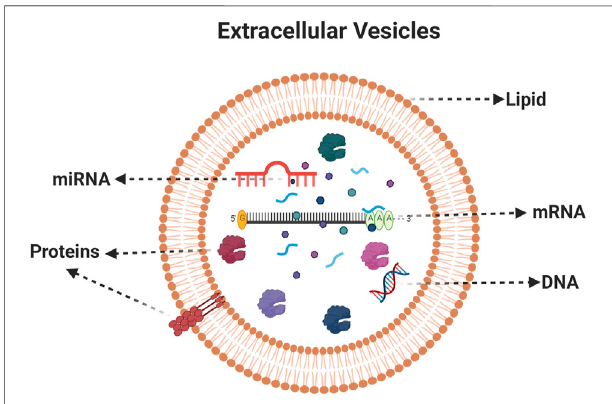
FIGURE 2 | Composition of extracellular vesicles. A typical EVs consists of Lipids, proteins, mRNA, miRNA and DNA. Created with BioRender.com.